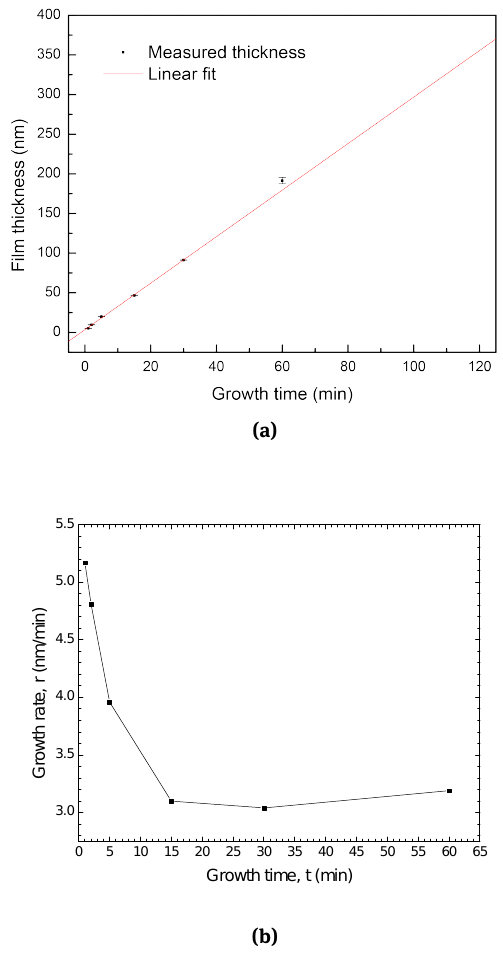
Figure 2: Dynamics of NCG films growth: (a) thickness and (b) growth rate